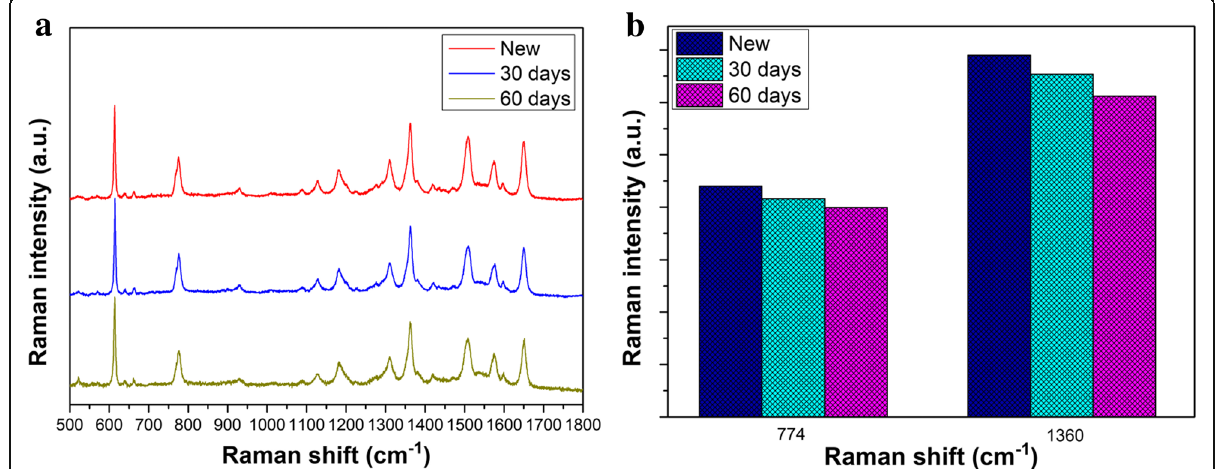
Fig. 7 a Raman spectra of 10 − 7 M Rh6G on the GNR vertical array substrate with different days. b Comparison with the intensities of SERS signals at peaks of 774 cm − 1 and 1360 cm −